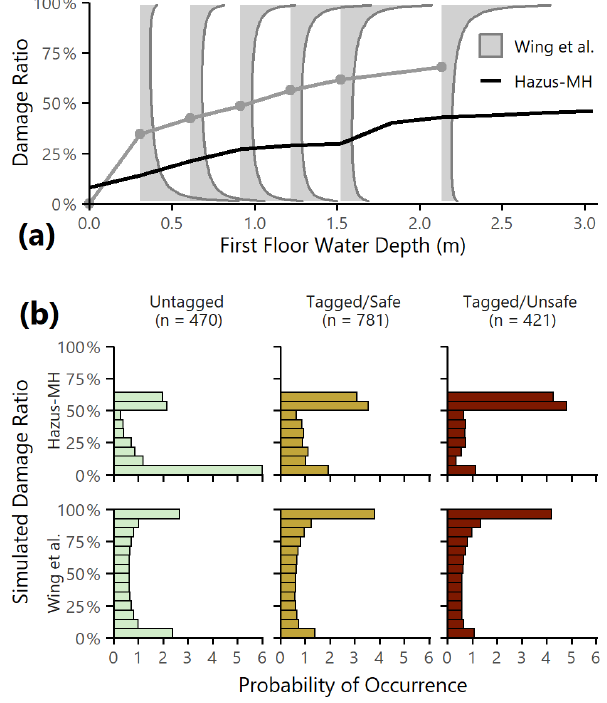
Figure 8. Damage component model. (a) Depth–damage rela- tionships from Wing et al. (2020) and from Hazus-MH. The light gray areas represent the shapes of the beta distributions for the five defined curves (1ft = 0.30m, 2ft = 0.61m, 3ft = 0.91m, 4ft = 1.22m, 5ft = 1.52m, 7ft = 2.13m), and the gray line follows the distribution means. The black line is the Hazus-MH depth– damage function for single-story residential buildings without a basement. (b) Damage ratio distributions for inundated buildings based on 1000 Monte Carlo realization, using Hazus-MH (top panel) and Wing et al. (2020) (bottom panel) depth–damage rela- tionships and grouped by safety category.